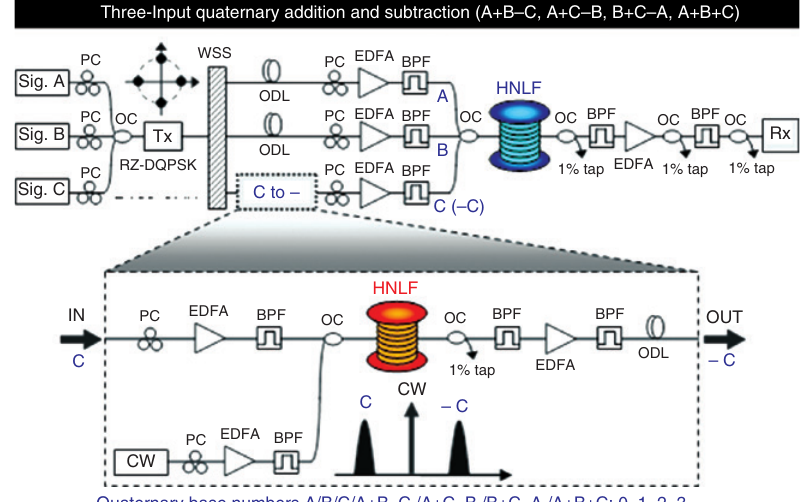
Figure 15: Modular arithmetic system design.